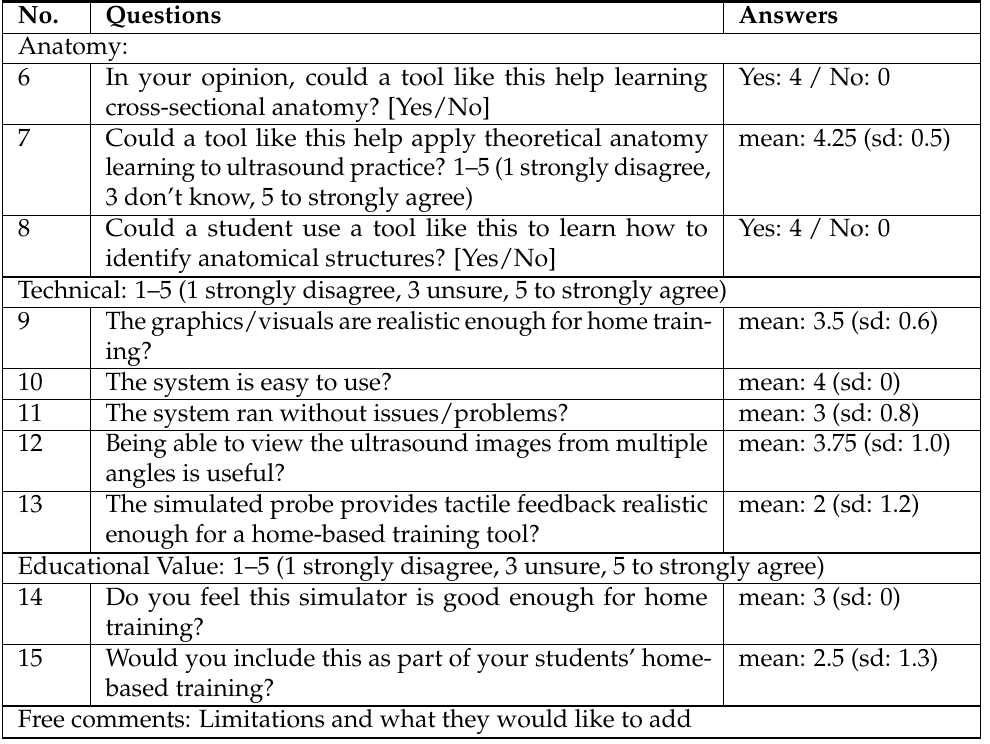
Table 1. Medical ultrasound lecturers